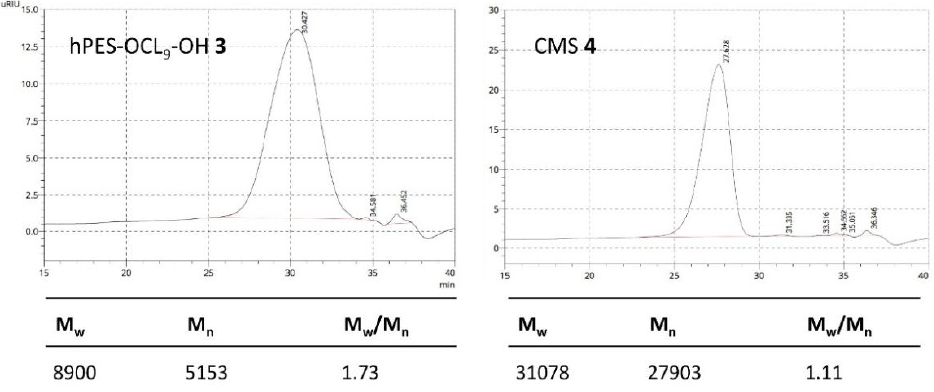
Figure A7. GPC elugram of purified hPES-OH 2 in THF. Polymers 2016 , 8 , 192